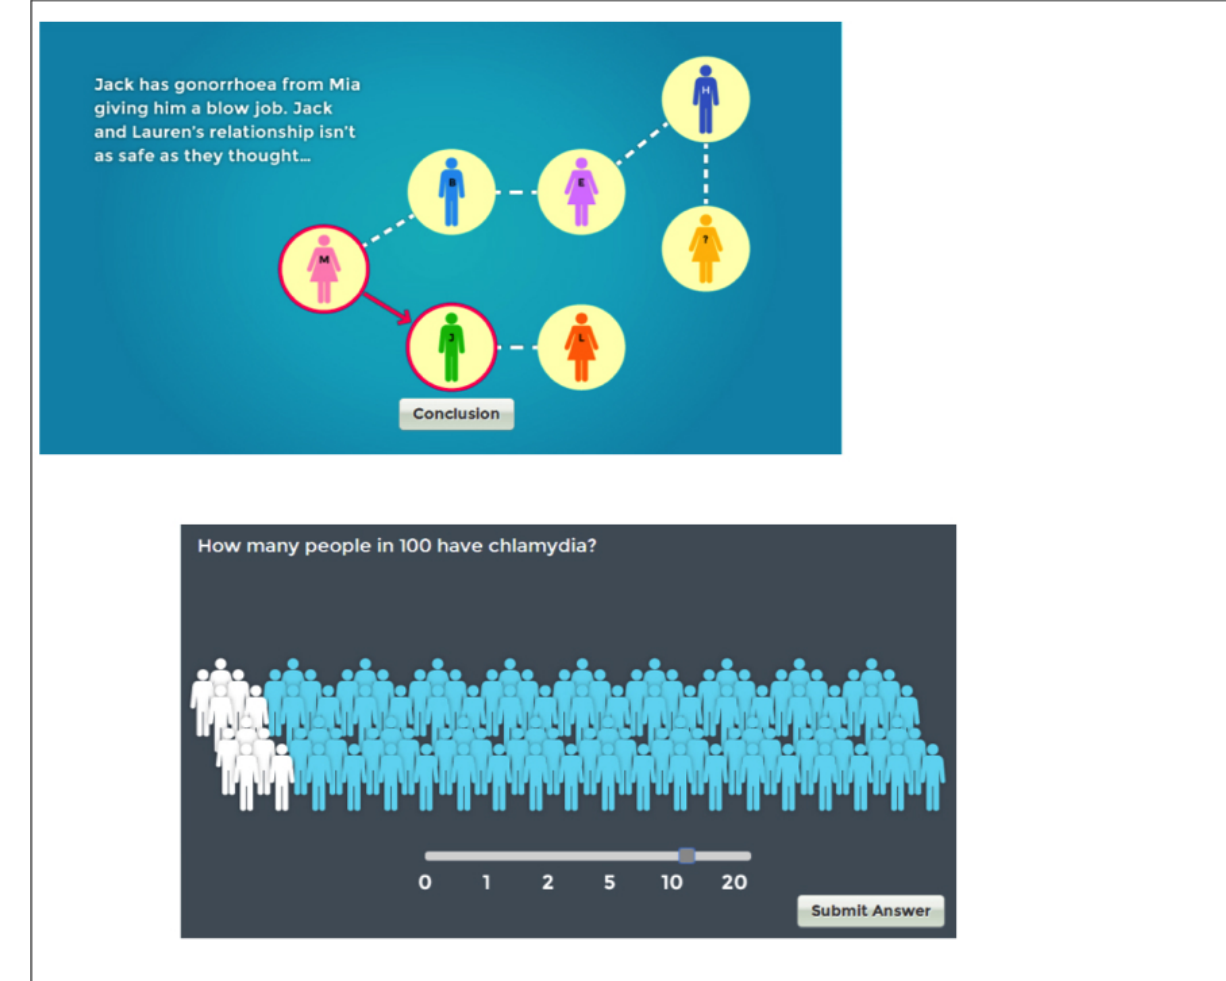
Figure 5. STIs: Are you at risk? – infographics illustrating potential risks of